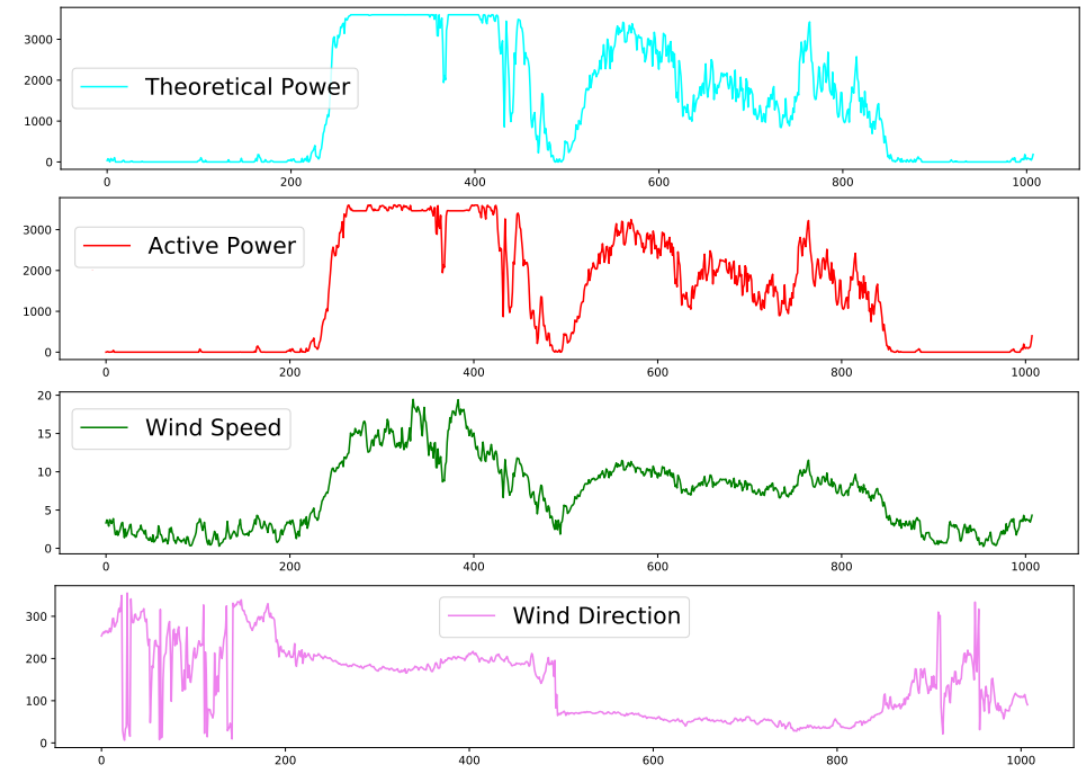
Figure 2. One week data representation of wind turbine gathered by supervisory control and data acquisition (SCADA)